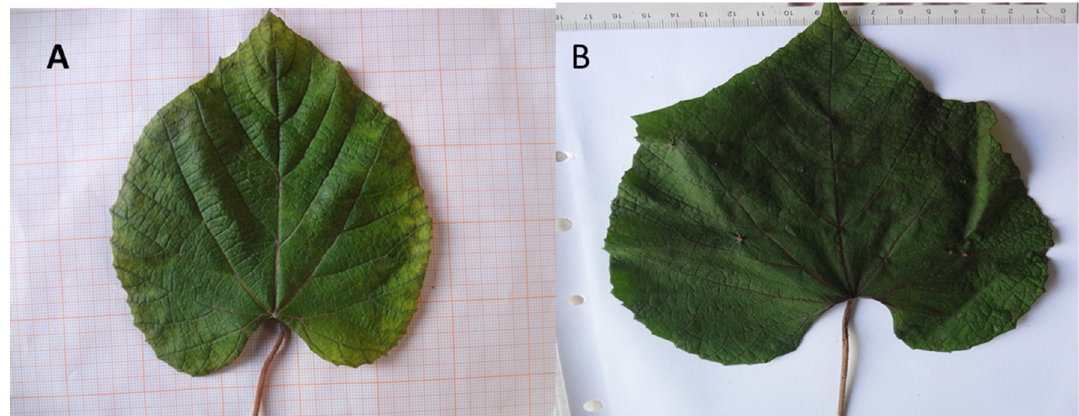
Figure 13. Leaves of V. tiliifolia ( A ) locality of Atlahuilco ( B ) locality of Ixtaczoquitlán.